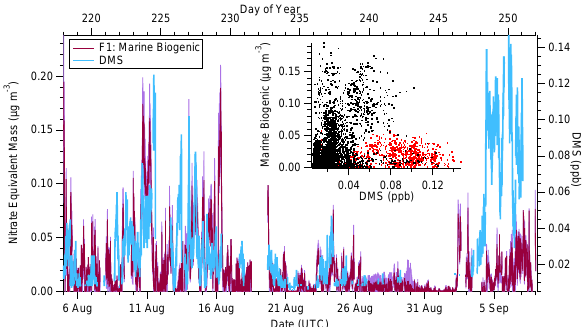
Fig. 5. Time series of the Marine Biogenic factor and DMS. The inset is a scatter plot of these two quantities, with the black points excluding the last week of the study and the red points only repre- senting the last week of the